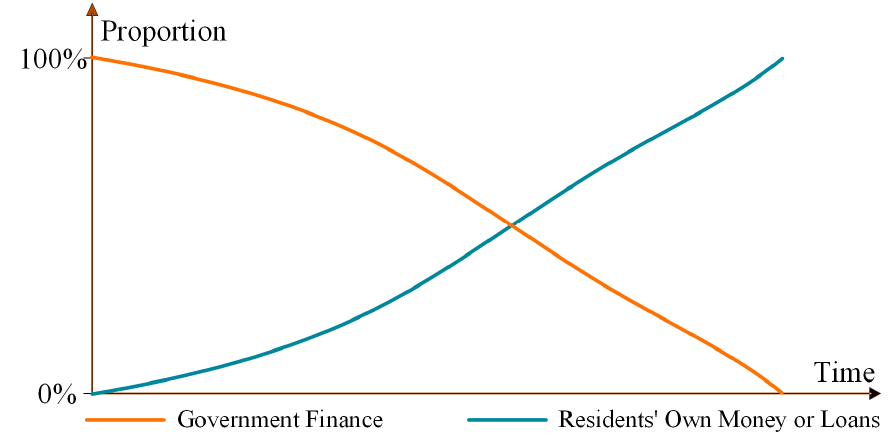
Figure 6. Degressive subsidies in housing conservation and renovation.